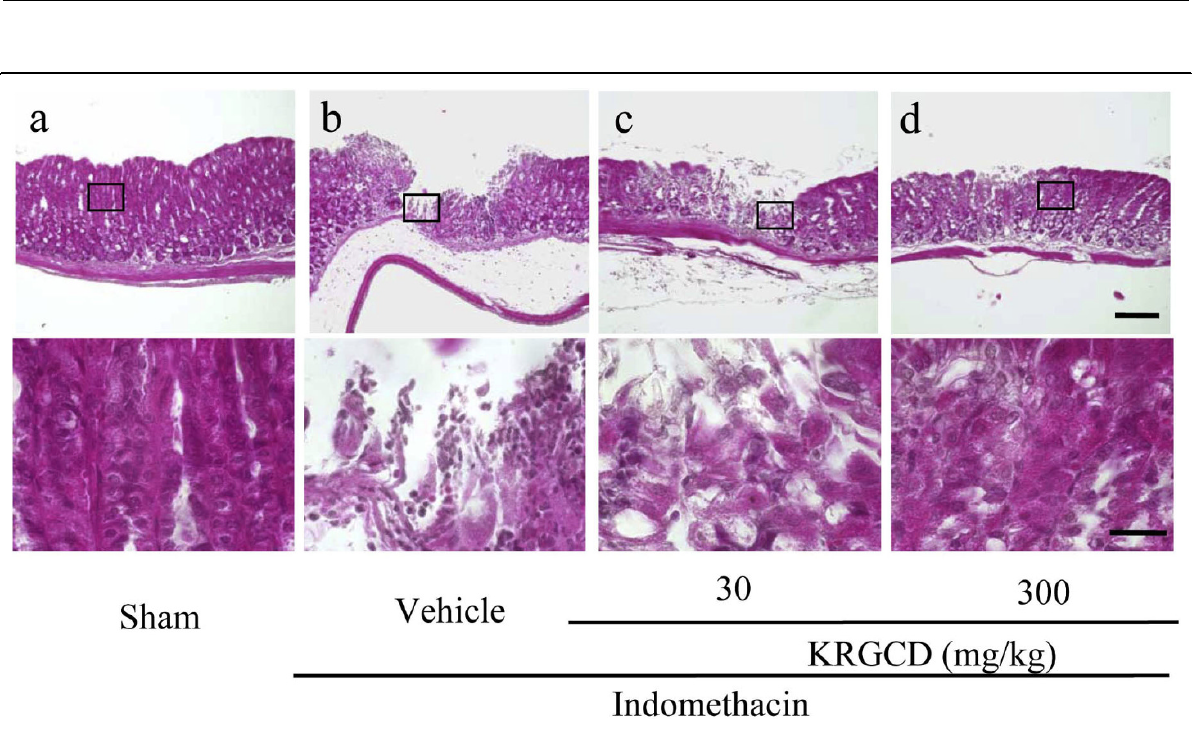
Figure 4 Effect of KRGCD on histological evaluation in indomethacin-induced ulcer model . Sections of hematoxylin and eosin (HE) staining (a-d). Section through gastric mucosa in the sham treated group (a). Microscopic appearance of lesions induced by indomethacin in gastric mucosa pretreated with vehicle (b). Microscopic appearance of lesions pretreated with 30 mg/kg of KRGCD (c). Microscopic appearance of lesions pretreated with 300 mg/kg of KRGCD (d). Scale bar = 150 μ m (upper micrograph) and 30 μ m (lower